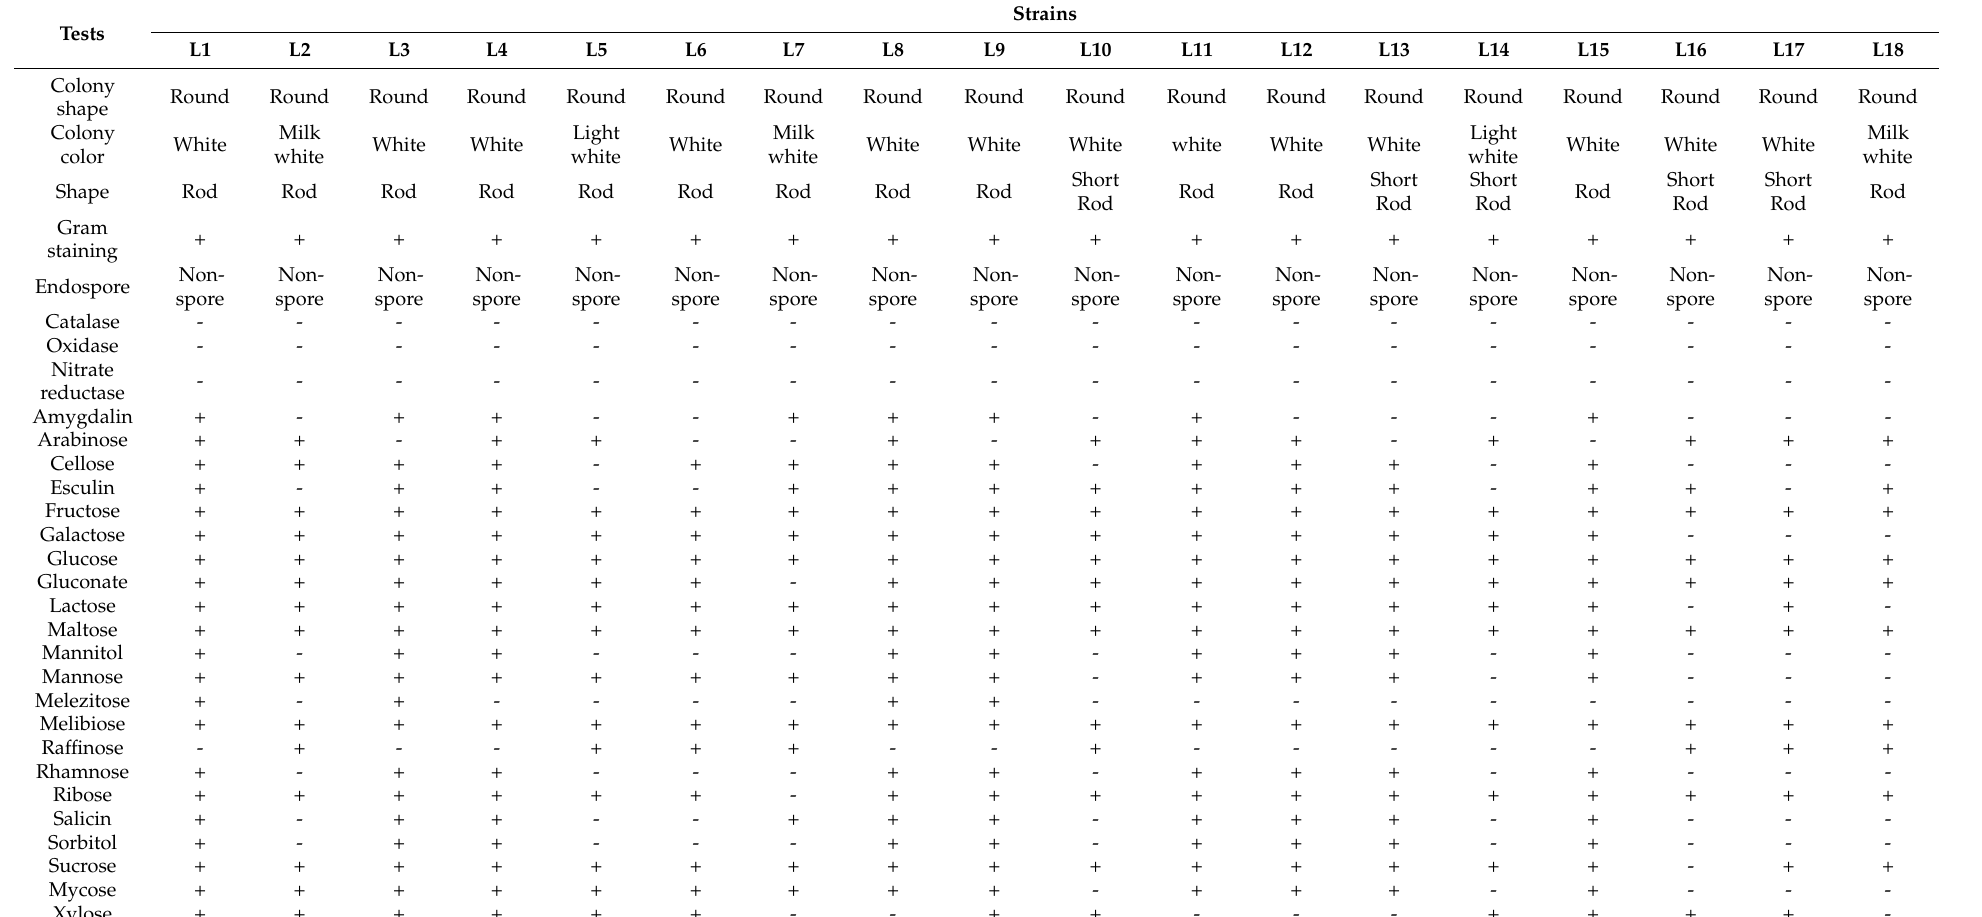
Table 1. Morphological and physicochemical results of 18 LAB